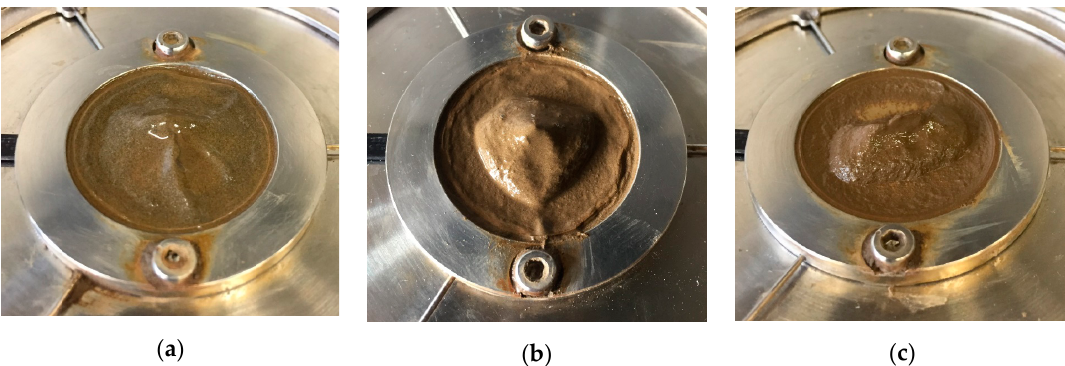
Figure 10. Interfaces between cementitious paste and upper rotating plate after rheological tests. ( a ) 0.4_3%MNPs (0.25T)_Shearing, ( b ) 0.4_3%MNPs (0.5T)_No shearing, and ( c ) 0.32_0.5%PCE_3%MNPs